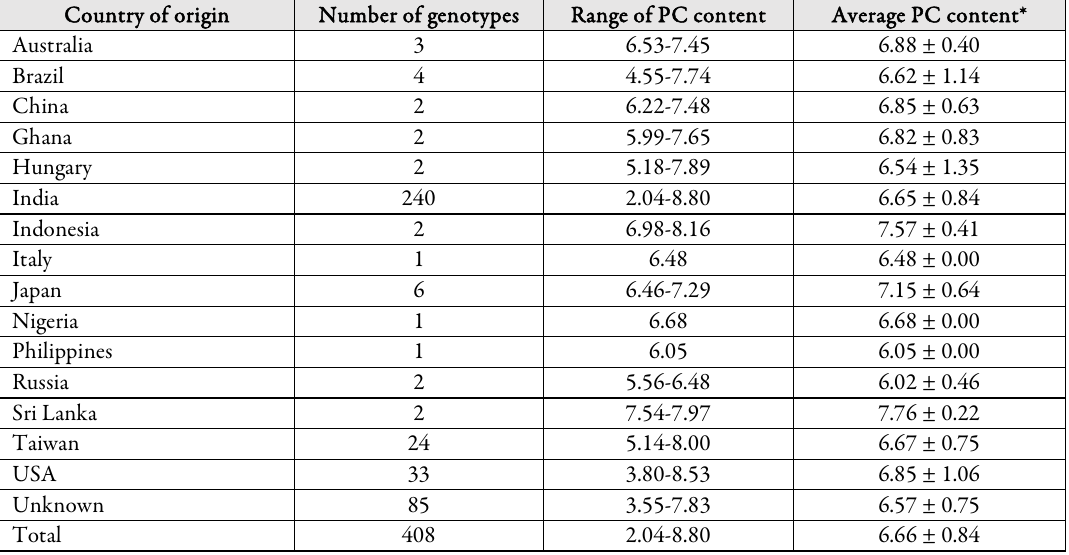
Total *Values given are average of phosphatidylcholine content of total soybean genotype from given country ± standard